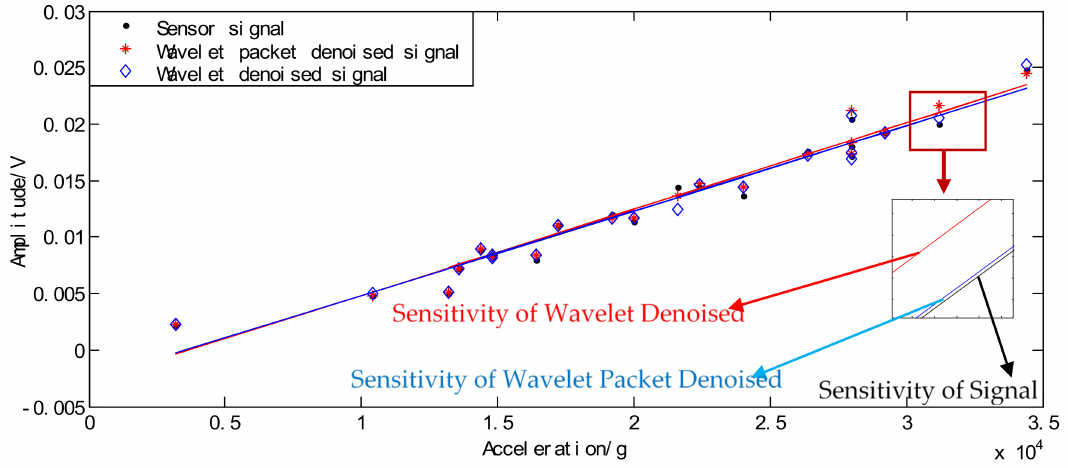
Figure 15. Static sensitivity fit diagram.